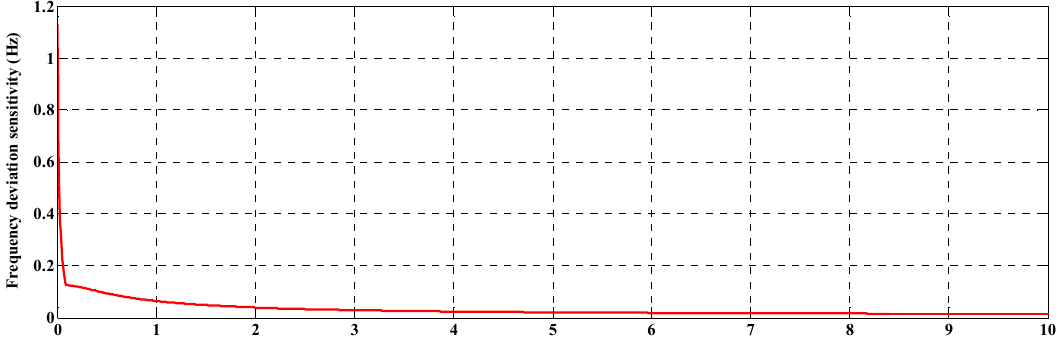
Table 3. Sensitivity analysis for the proposed controller under ±25% variations in T DEG and T FC.